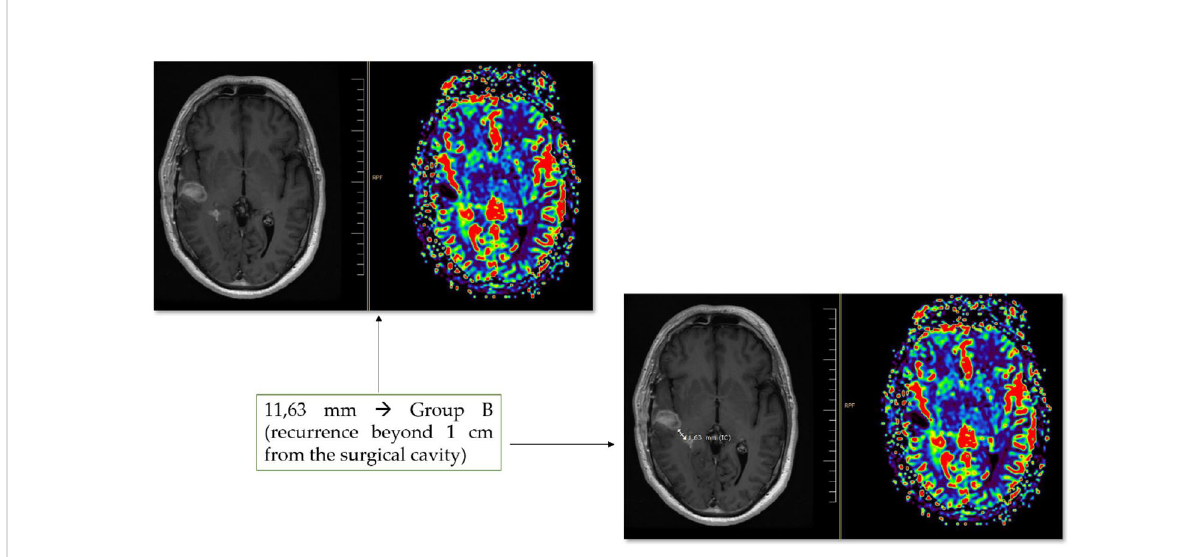
FIGURE 1 An example of the location of recurrence evaluation is provided. In this fi gure, a unique recurrence is detected at 11,63 mm from the surgical cavity. It allows us to classify the patient in group B MRI perfusion sequences may help both detect the recurrence and discard pathological gadolinium uptake at the margins of the surgical